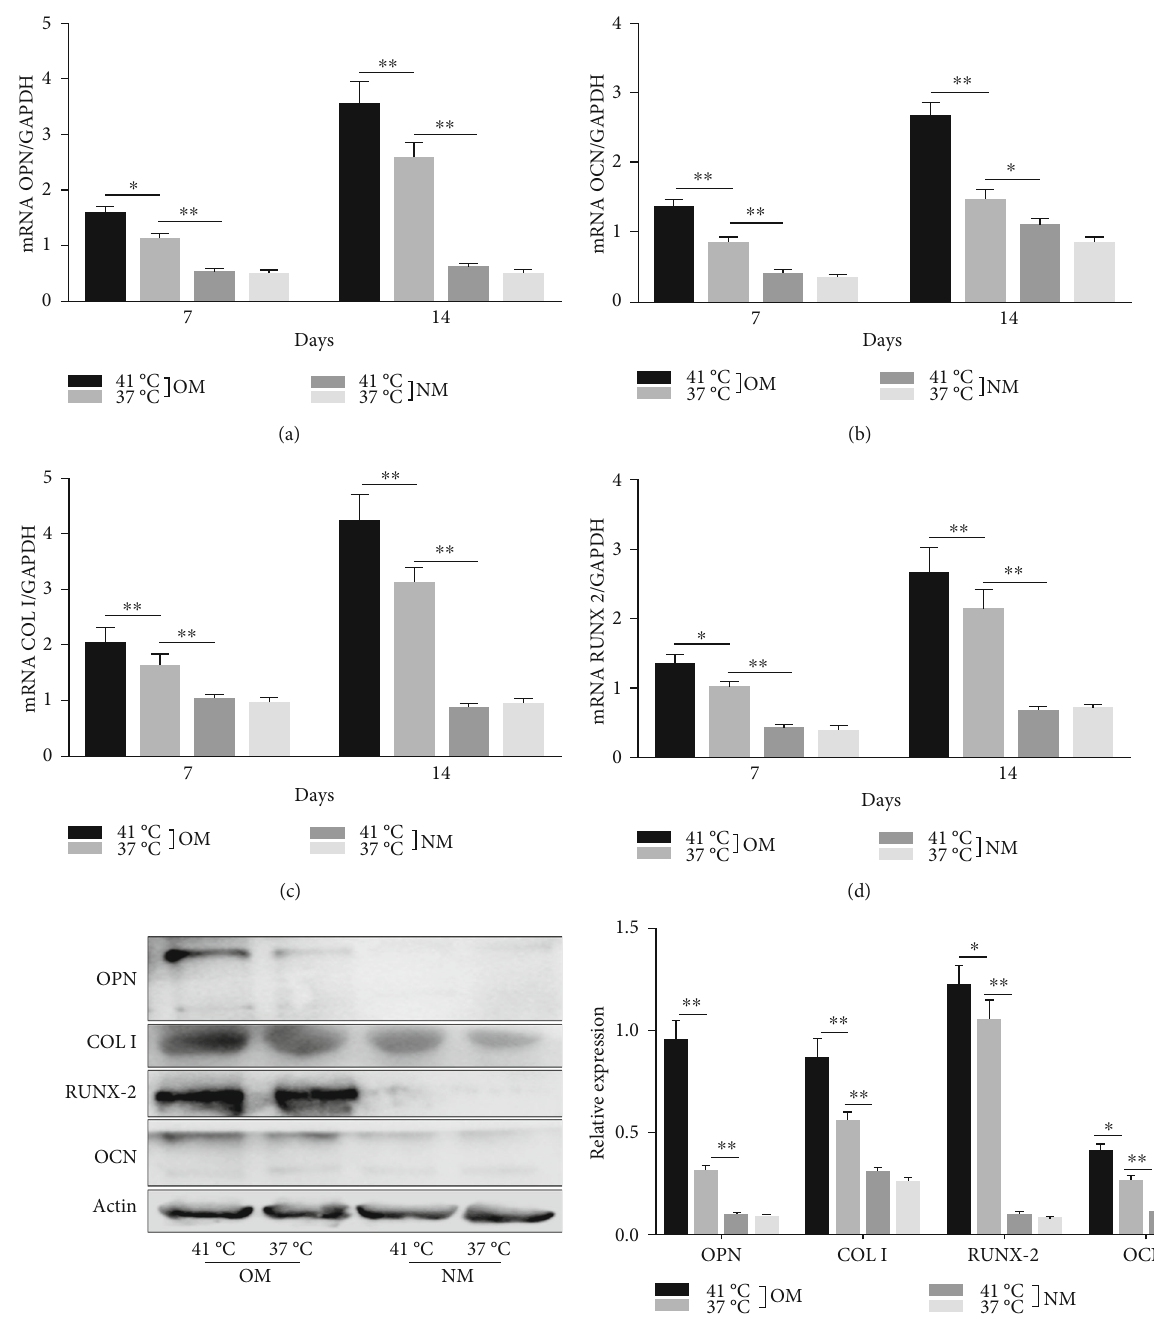
Figure 4: Osteogenesis of EMSCs. The expression of osteogenic genes, including OPN, OCN, COL I, and RUNX2, was increased substantially in the heat stress-treatment group compared with the control groups after osteogenic di ff erentiation for 7 days and 14 days. (e) Increased levels of osteogenesis-associated proteins in heat stress-treated EMSCs. (f) Changes in the expression of bone-speci fi c proteins on day 14 of di ff erentiation, as detected by western blotting. OM=osteogenic-inducing media; NM=normal media. ∗ P < 0 : 05 and ∗∗ P < 0 : 01